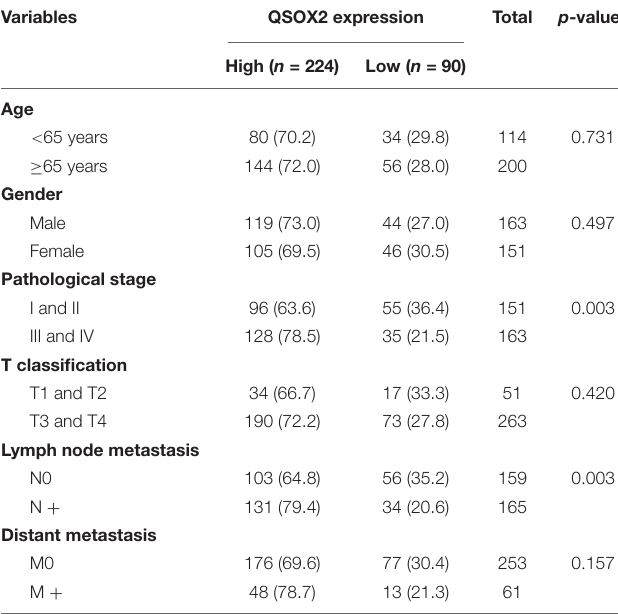
TABLE 3 | The relationship between quiescin sulfhydryl oxidase 2 (QSOX2) expression and CRC clinicopathological features based on TCGA cohort.